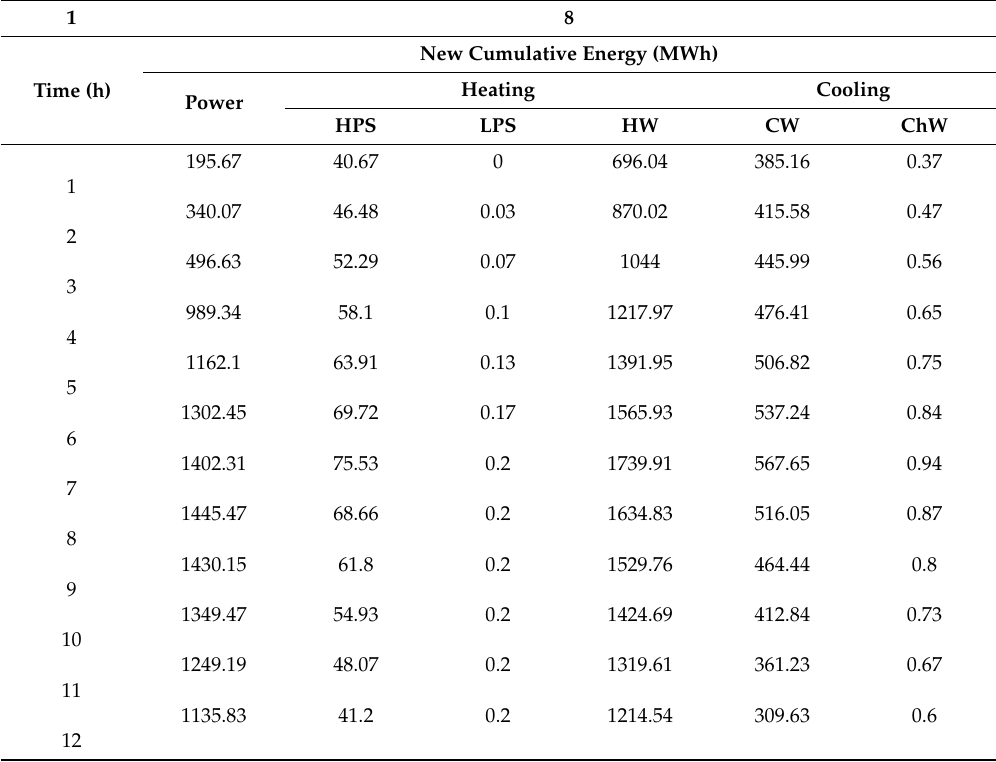
Table A25. TriGenSCA for final trigeneration PWR NPP without integration from 1 to 12 h. 1